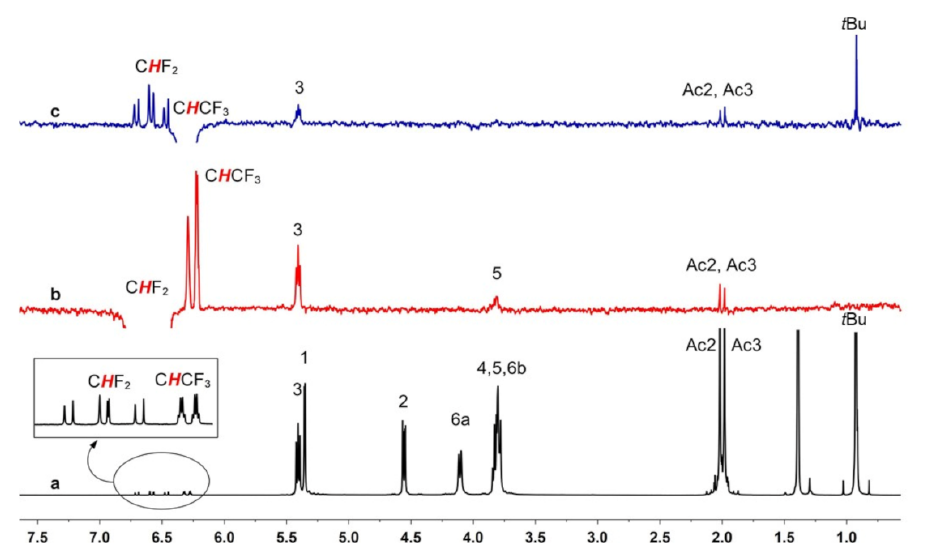
Figure 4. 1 H (600 MHz, 25 ◦ C, C 6 D 12 ) NMR spectrum of racemic 1-to-1 ISO/AcSi γ CD mixture ( a , black) and 1D-ROESY (600 MHz, 25 ◦ C, C 6 D 12 , mixing time = 400 ms) spectra of CHF 2 ( b , red) and CHCF 3 ( c , blue) resonances.